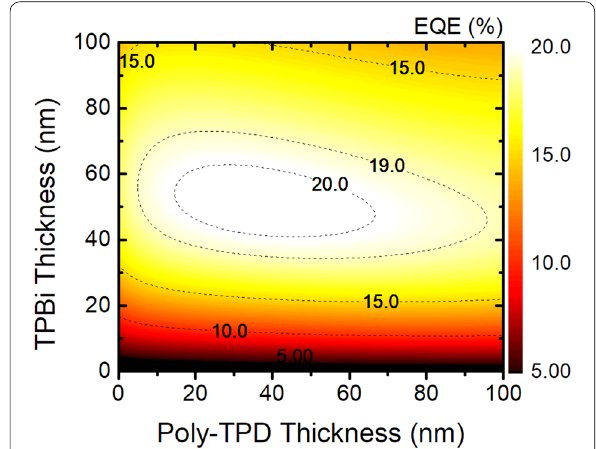
Fig. 4 Contour plot of the maximum achievable EQE of the PeLED as a function of the thicknesses of the transporting layers, poly‑TPD, and